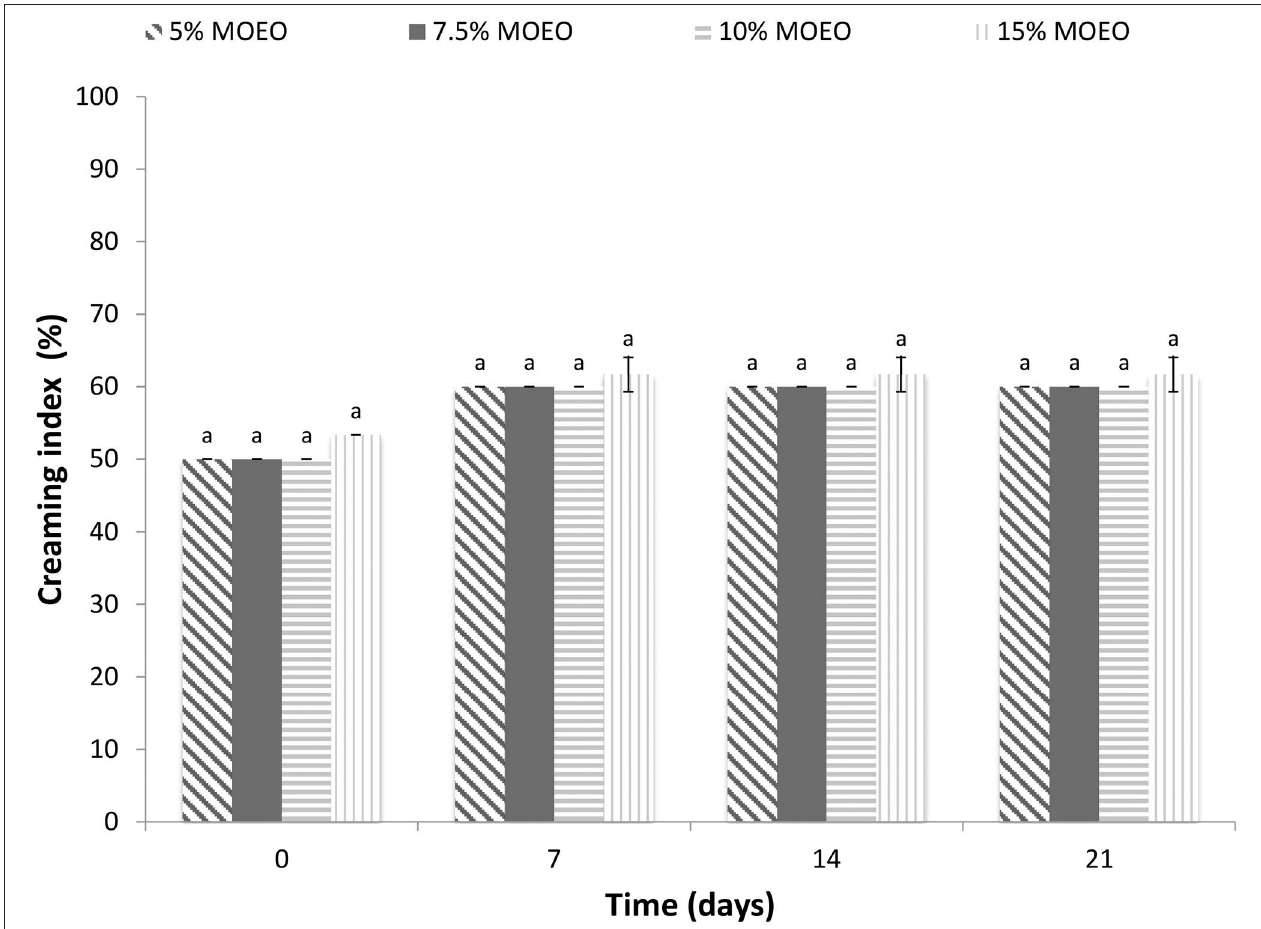
FIGURE 3 | Creaming index of emulsions stabilized with pectin at different concentrations of Mexican oregano essential oil (MOEO), stored at 25 ◦ C, during 21 days of observation. Systems that do not share the same letter at each time are significantly different ( p <